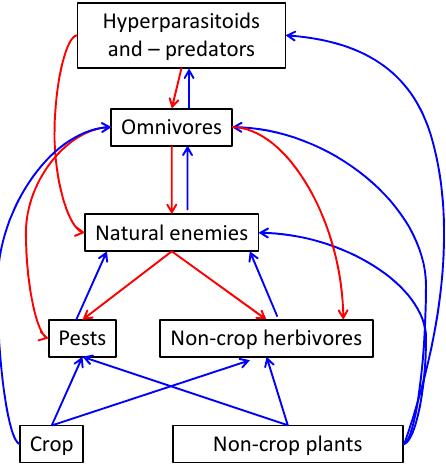
Figure 1. Possible direct and indirect effects of plant biodiversity on the assemblage of pests and other arthropods (after Gurr et al. 2003) [9]. Blue lines represent positive, and red lines negative effects. Combinations of direct effects yield indirect effects (not shown here).